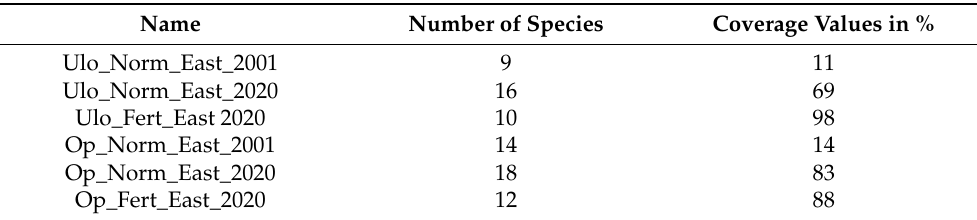
Table 5. Changes in the number of species on the east area with sedum cuttings from 2001 to 2020, 10-cm